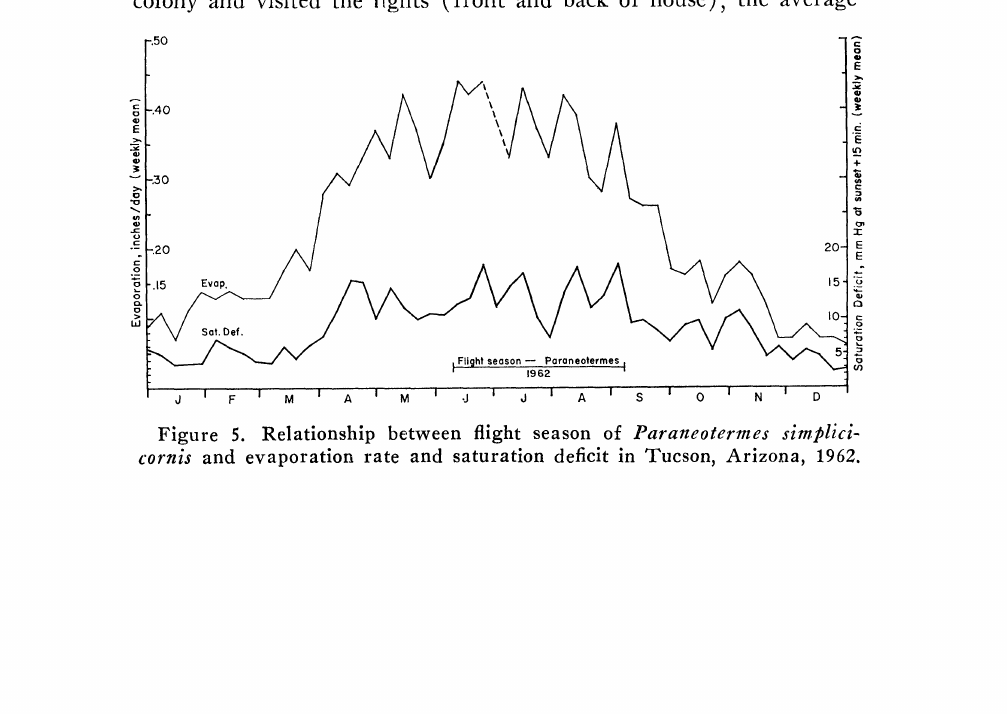
Figure 5. Relationship between flight season of Paraneotermes simplici- cornis and evaporation rate and saturation deficit in Tucson, Arizona,